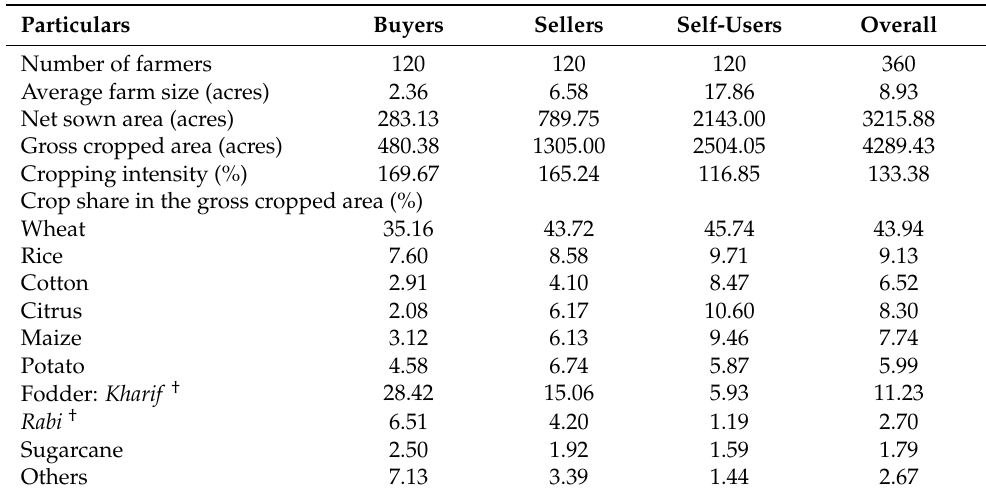
Table 1. Cropping pattern, cropping intensity, and total cropped area across the water